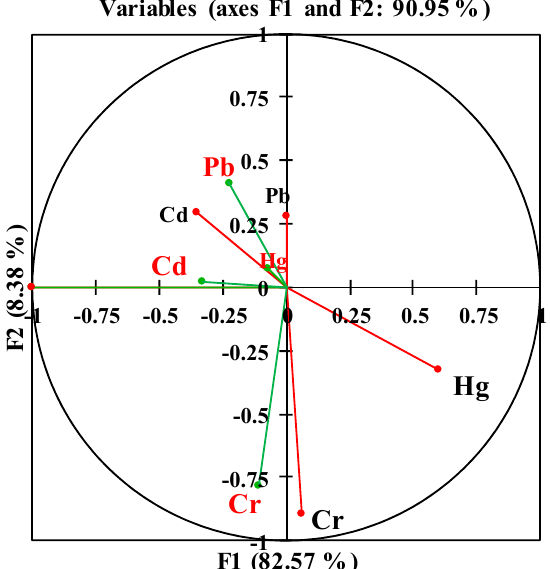
Figure 2. Ordination diagram based on the CCA of the heavy metal (Cd, Hg, Pb, and Cr) in soil (in black) and heavy metal (Cd, Hg, Pb, and Cr) in the rice grain (in red).